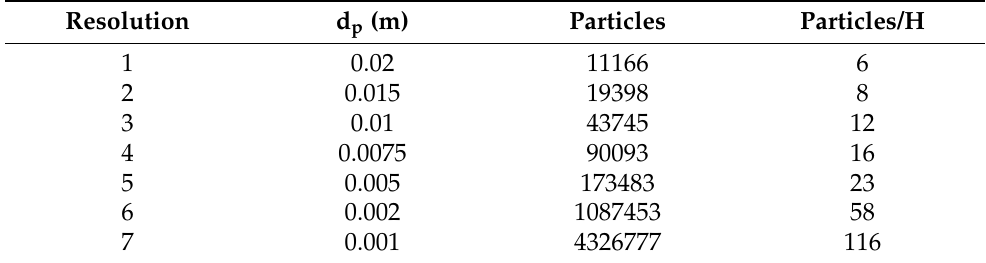
Table 9. DualSPHysics domain resolutions (with total number of particles per H).